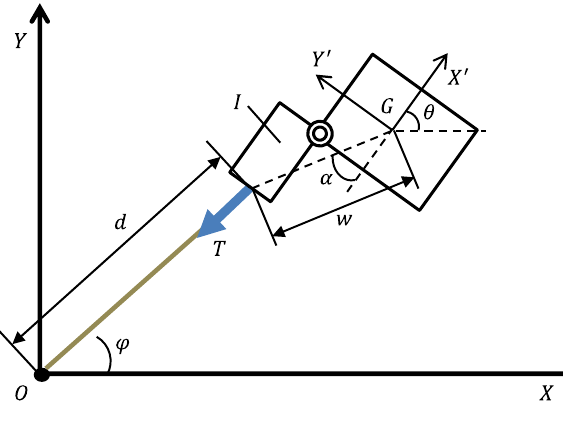
Figure 6. Model of TSMD when tether is under tension.